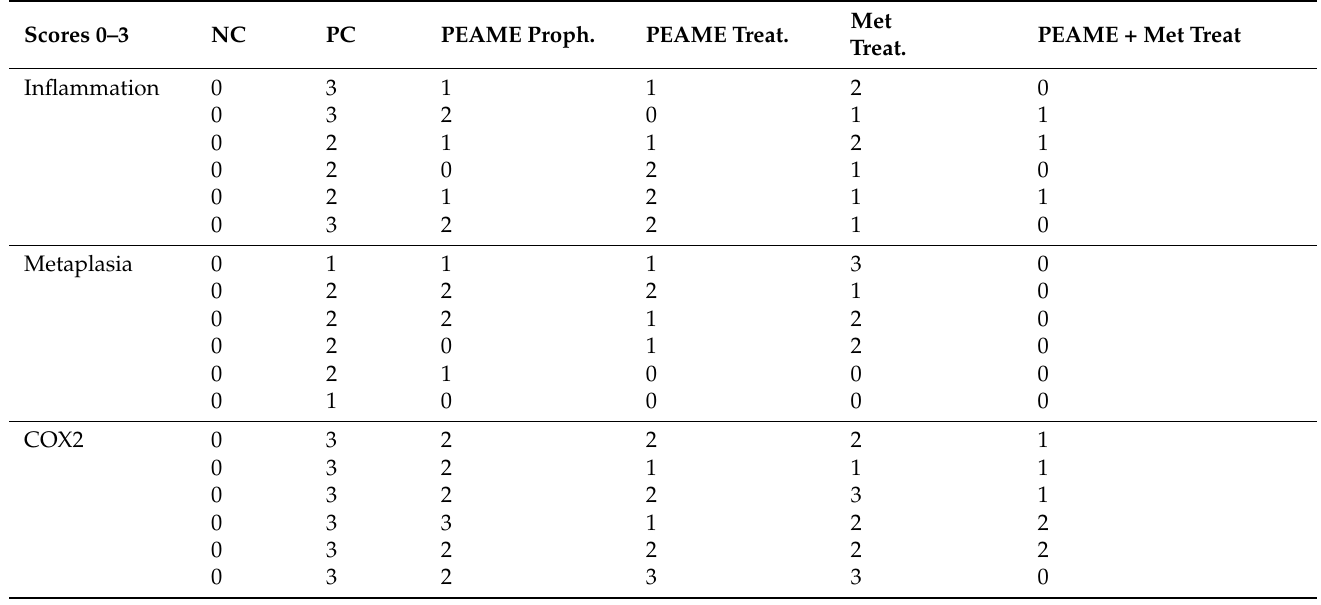
Figure 9. Microscopic pictures of H&E-stained glandular gastric mucosa from H. pylori infected rats taking prophylactic PEAME ( A1 – A6 ) showed metaplasia (black arrows), submucosal congestion (red arrows), apoptosis (blue arrows) with low mononuclear cell infiltration (yellow arrows). Meanwhile, the glandular gastric mucosa from H. pylori infected rats co-treated with PEAME and metronida- zole ( B1 – B6 ) showed improved histology with mild apoptosis (blue arrows). Low magnification X: 100 bar 100 and high magnification X: 400 bar 50. Table 5. Effect of H. pylori infection, PEAME, and metronidazole on the score of inflammation, metaplasia, and COX2 in the stomach mucosa of